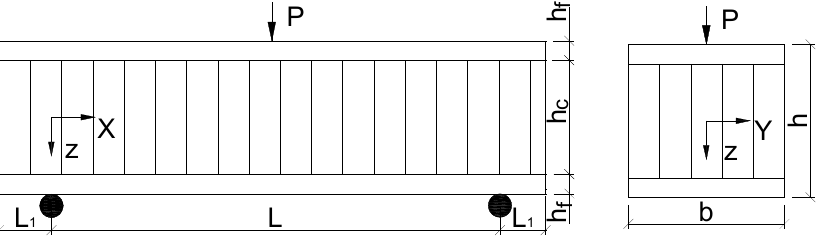
Figure 7. Specimen notation considered for the analytical models.